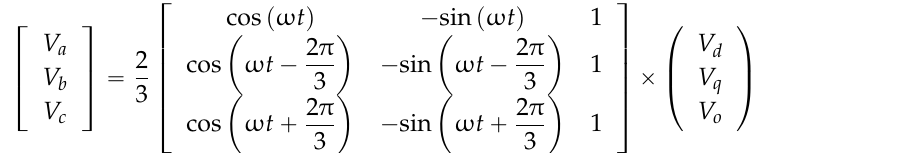
Figure 2, namely, E and CE , at the t th sampling step that corresponds to (cid:1848) (cid:3031) can be described as follows: